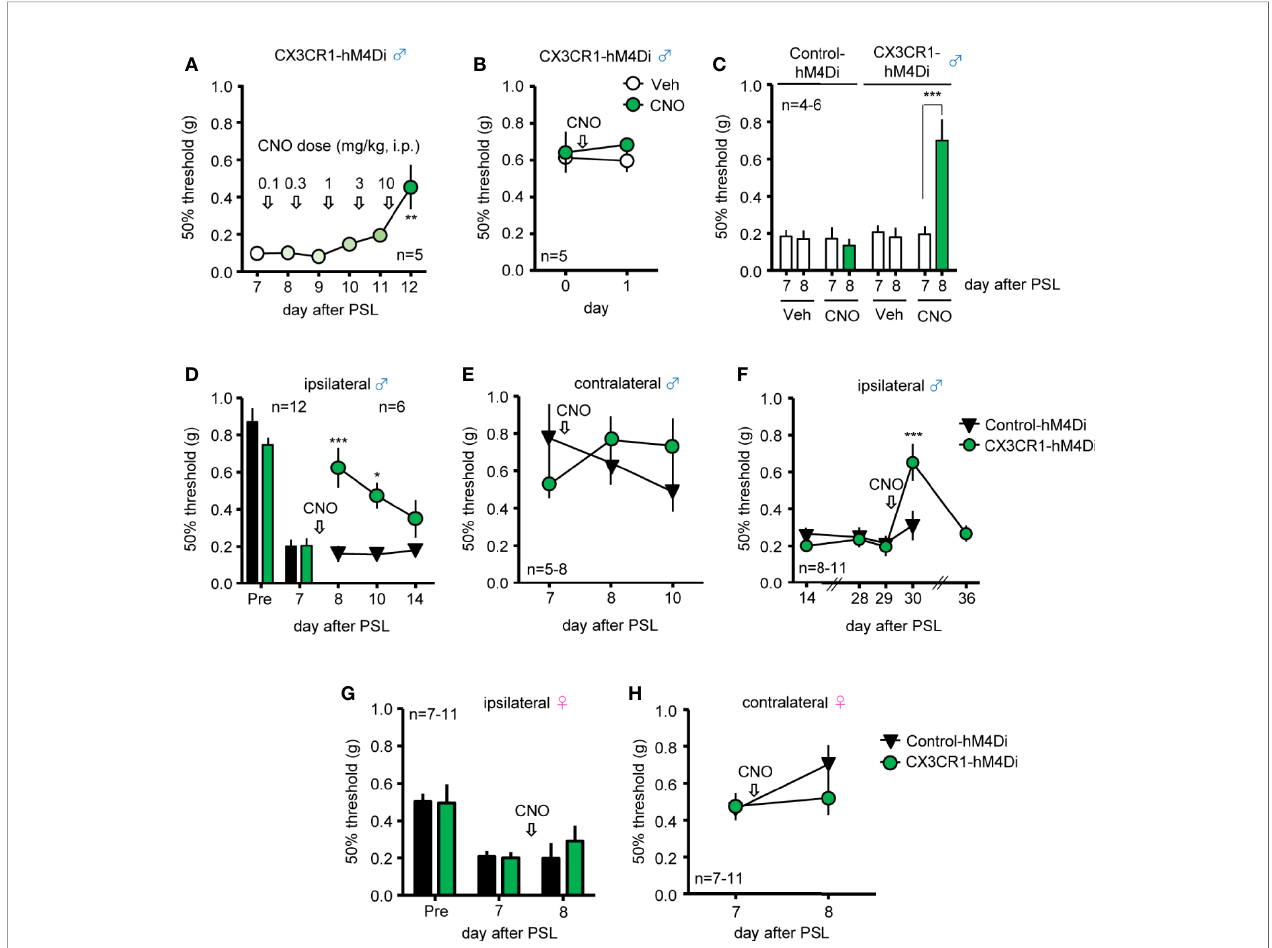
FIGURE 2 | Relief of mechanical allodynia after PSL by systemic CNO in male CX3CR1-hM4Di mice. The mice were subjected to PSL, and CNO was intraperitoneally (i.p.) administered as follows: (A) Increasing doses of CNO (0.1-10 mg/kg, i.p.) were administered daily from days 7 to 11 after PSL, and pain assessment was performed the next day after each administration. (B – H) CNO was i.p. administered after pain assessment as indicated by arrows. The 50% paw withdrawal threshold was assessed by the up – down method using the von Frey test. (A) Effects of different doses of CNO (0.1-10 mg/kg) on mechanical allodynia after PSL were evaluated 24 h after each CNO administration (before next doses) in male CX3CR1-hM4Di mice. (B) No effect of CNO (10 mg/kg) on 50% paw withdrawal threshold in naïve male CX3CR1-hM4Di mice. (C) Relieving effect of CNO (10 mg/kg) on PSL-induced mechanical allodynia in male CX3CR1-hM4Di mice. (D, E) Effect of CNO (10 mg/kg) on the 50% paw withdrawal threshold in the ipsilateral and contralateral side of male CX3CR1-hM4Di and Control-hM4Di mice after PSL. (F) Prolonged relieving effect of CNO (10 mg/kg) on mechanical allodynia in male CX3CR1-hM4Di and Control-hM4Di mice after PSL. (G, H) Effect of CNO (10 mg/kg) on the 50% paw withdrawal threshold in the ipsilateral and contralateral side of female CX3CR1-hM4Di and Control-hM4Di mice after PSL. Data are presented as mean ± S.E.M. n = 5-11. p***< 0.001, p** < 0.01, p* < 0.05 vs day 7 or day 29 before CNO, or